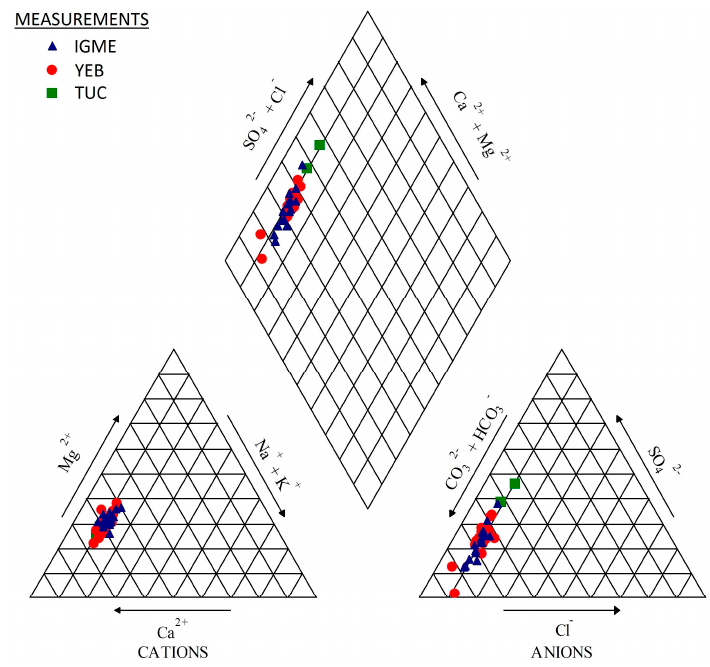
Figure 3. Trilinear diagram for representing analyses of groundwater quality.